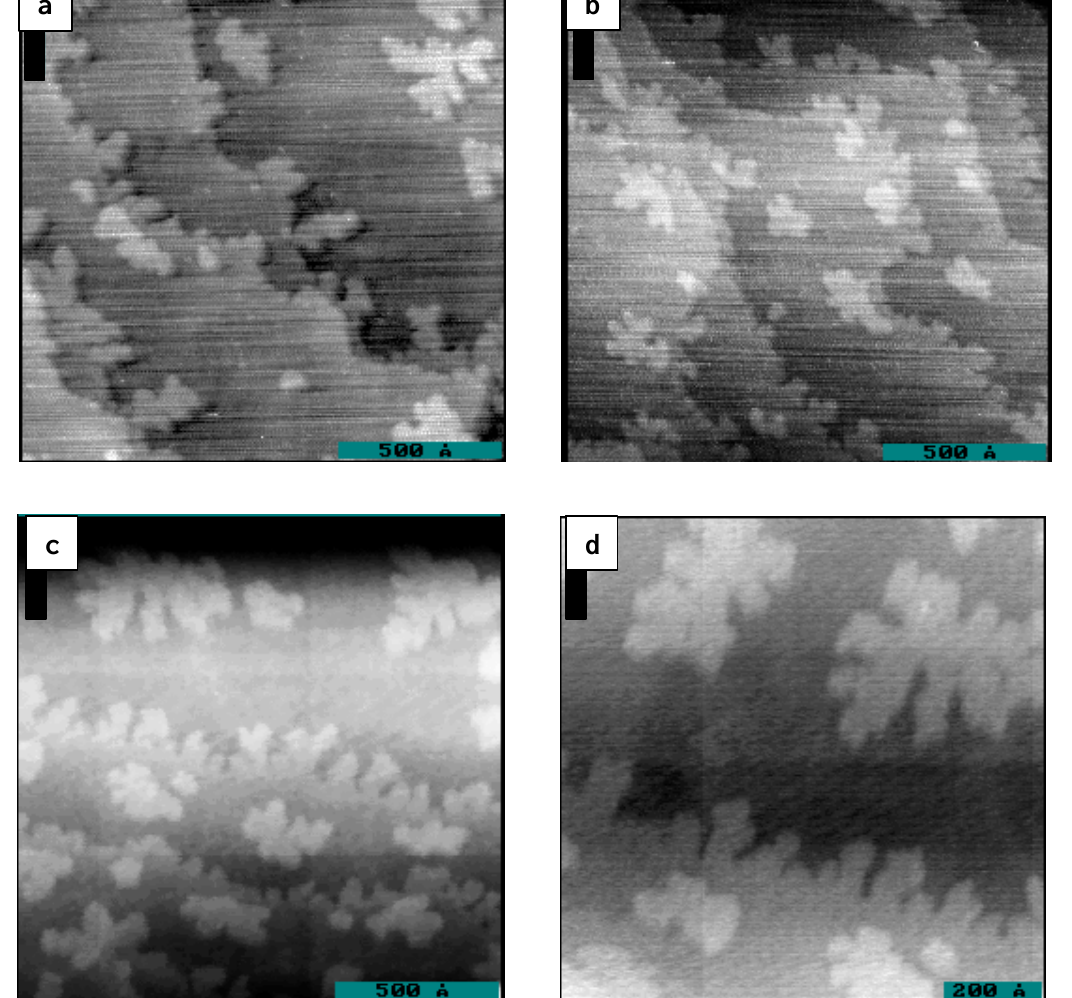
Figure 1 . STM pictures of the Co(0001) surface after Pt deposition. a-b: as-deposited, q (Pt) = 0.12 ML, 150 nm x 150 nm; c: annealed sample, q (Pt) = 0.18 ML, 150 nm x 150 nm. d: annealed sample, q (Pt) = 0.18 ML, 100 nm x 100 nm.